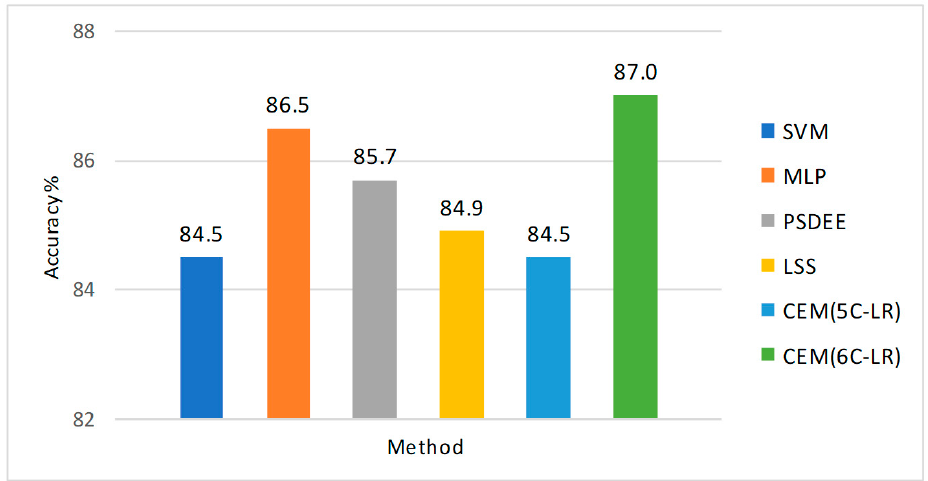
Figure 10. Results experimented on corpus Kitchen.